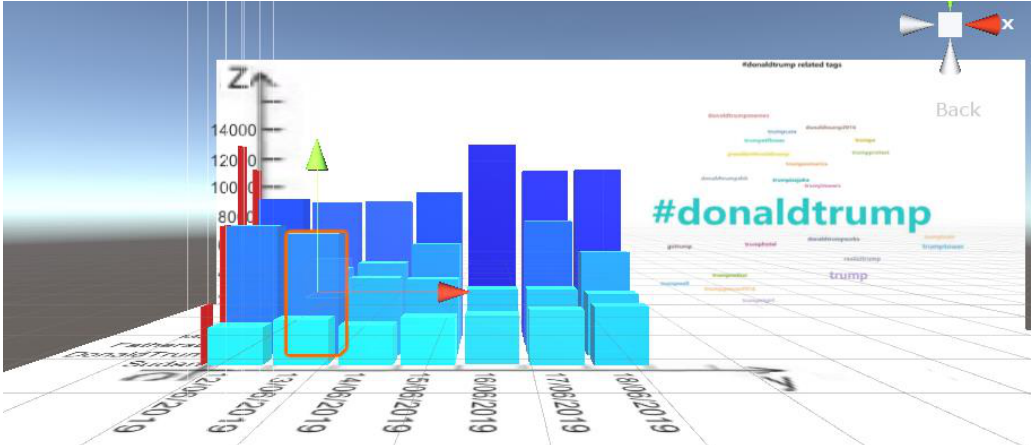
Figure 5 3D visualization system model of hashtag analysis